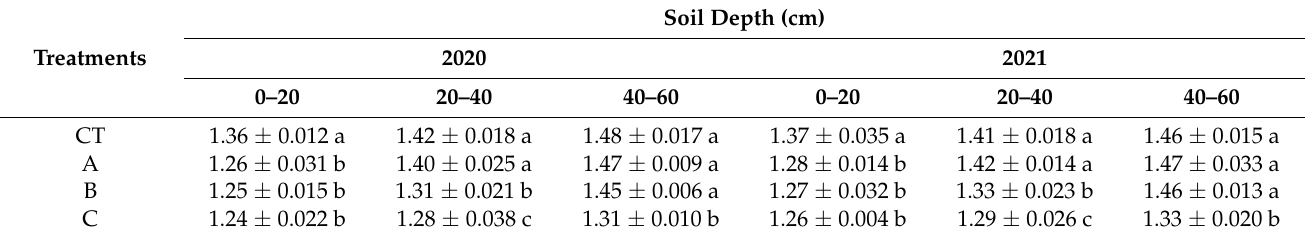
Table 2. Changes of soil bulk density at different soil layers under different treatments during cotton harvest.